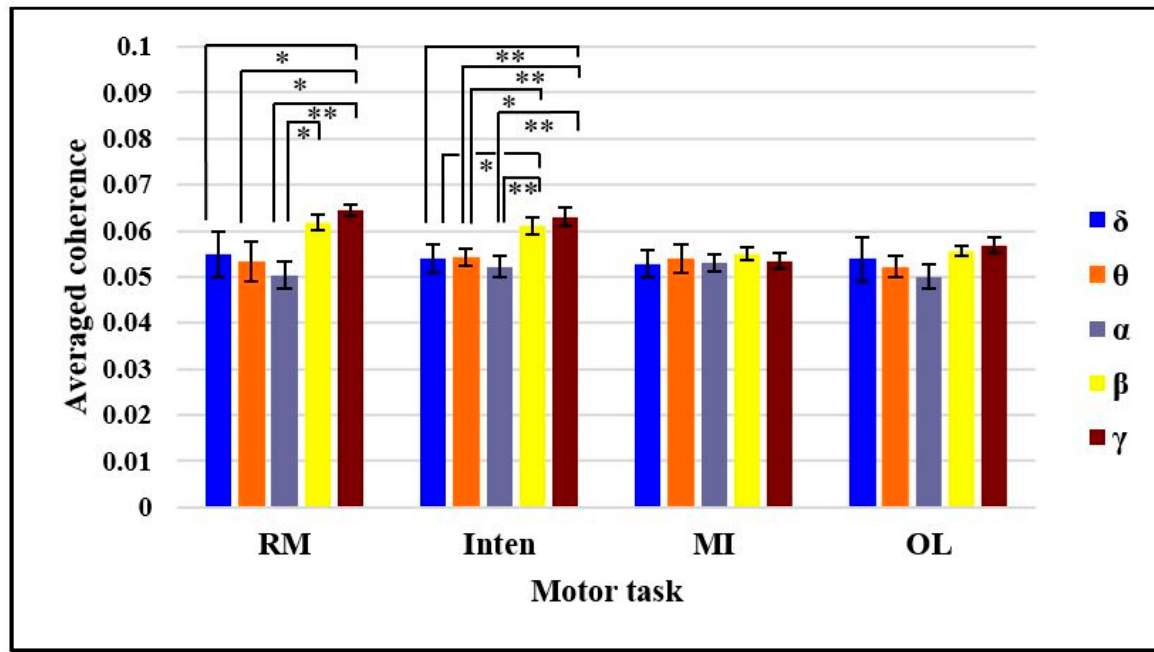
Figure 5. Comparison of the averaged coherence based on frequency band in four motor tasks. Error bars show the standard error of the mean. * p < 0.05 ** p < 0.01.